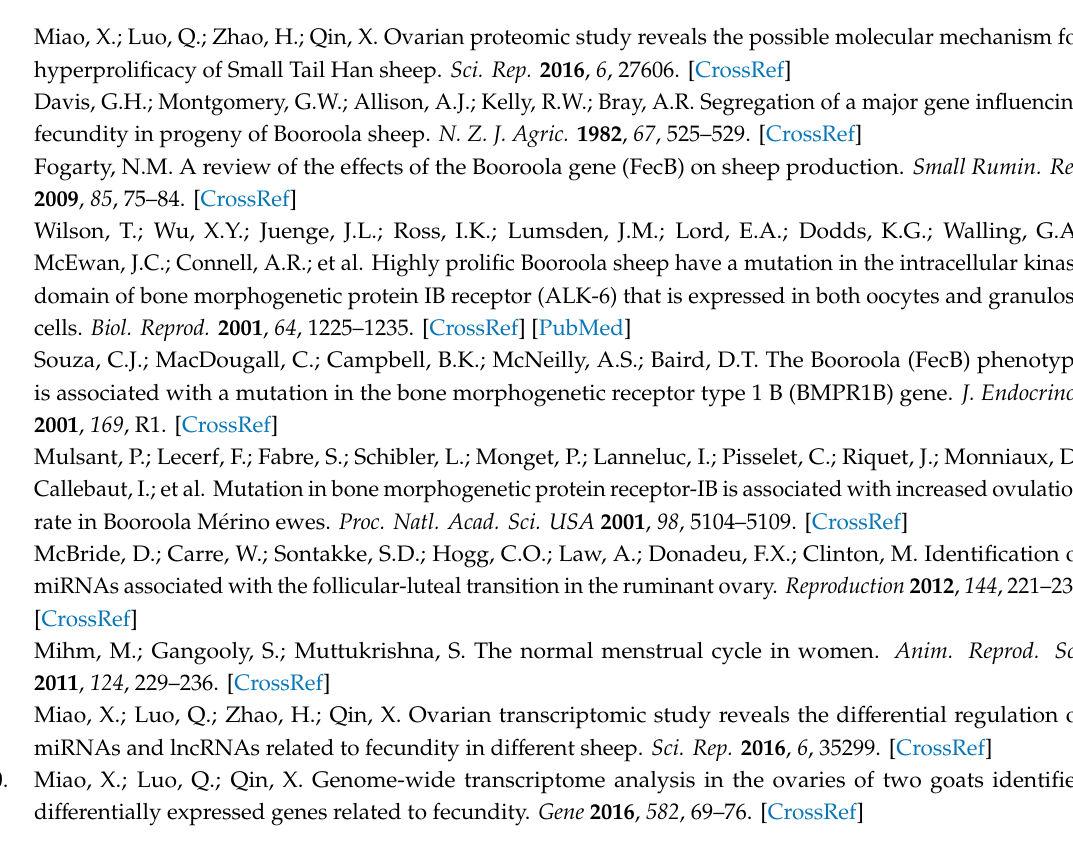
Table S1: Di ff erentially expressed circRNAs between PG and MG, Table S2: Enriched GO terms of host genes of di ff erentially expressed circRNAs, Table S3: Enriched KEGG pathways of host genes of di ff erentially expressed circRNAs, Table S4: List of circRNA-miRNA pairs to construct the interaction network. Author Contributions: Conceptualization, W.H., and M.C.; data curation, R.D., Q.L., X.W.; formal analysis, Y.L. and W.H.; investigation, J.T. and W.H.; methodology, L.Z.; project administration, W.H. and M.C.; resources, J.T., X.Z., and J.Z.; software, L.Z. and R.D.; supervision, W.H. and M.C.; validation, Y.L.; visualization, Y.L.; writing—original draft, Y.L.; writing—review and editing, Y.L., J.T., W.H., and